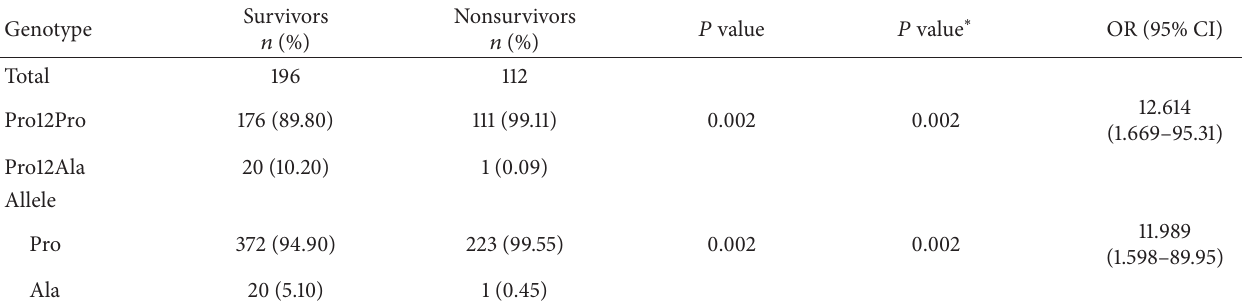
Table 4: Distributions of genotype and allele frequencies among surviving and nonsurviving